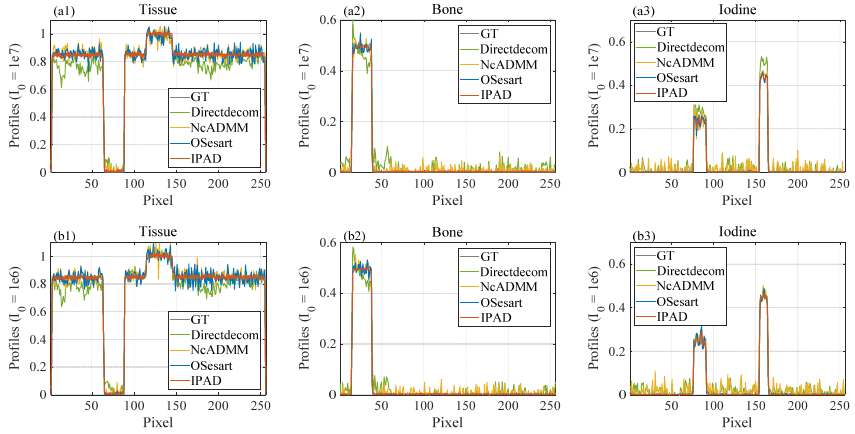
Figure 9. Profiles of different methods at different noise levels. ( a1 – a3 ), and ( b1 – b3 ) represent the profiles of tissue, bone, and iodine of different methods at two noise levels.